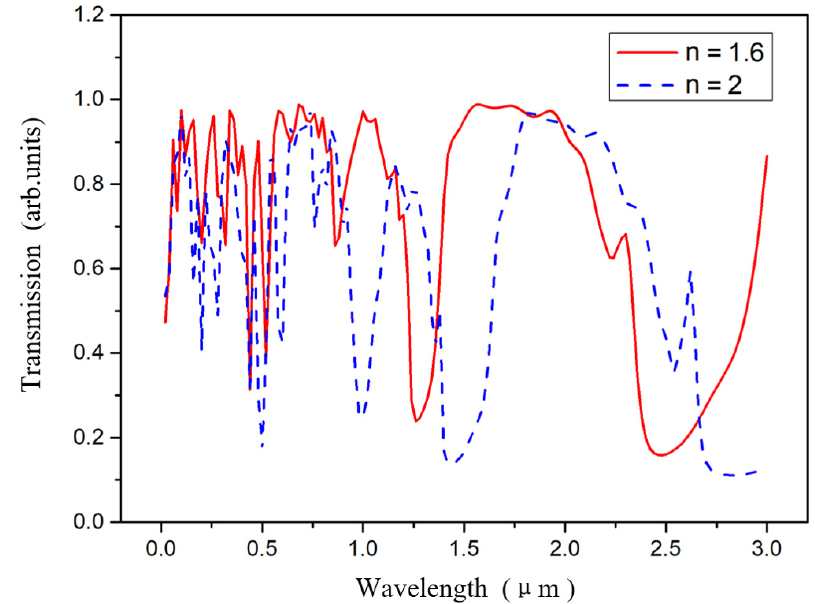
Figure 2. T ransmission spectra of 9-layer Sunflower flat lens with different refractive indexes. Figure 2. Transmission spectra of 9-layer Sunflower flat lens with different refractive